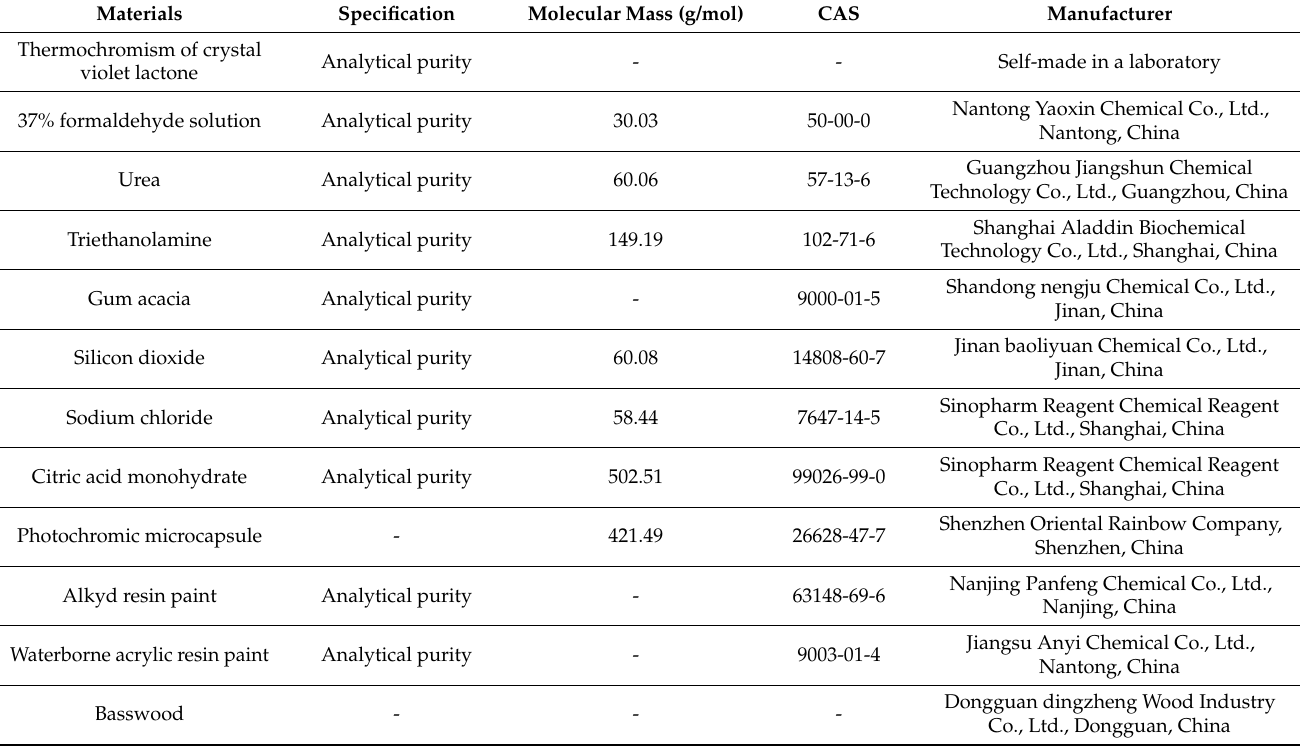
Table 1. List of experimental